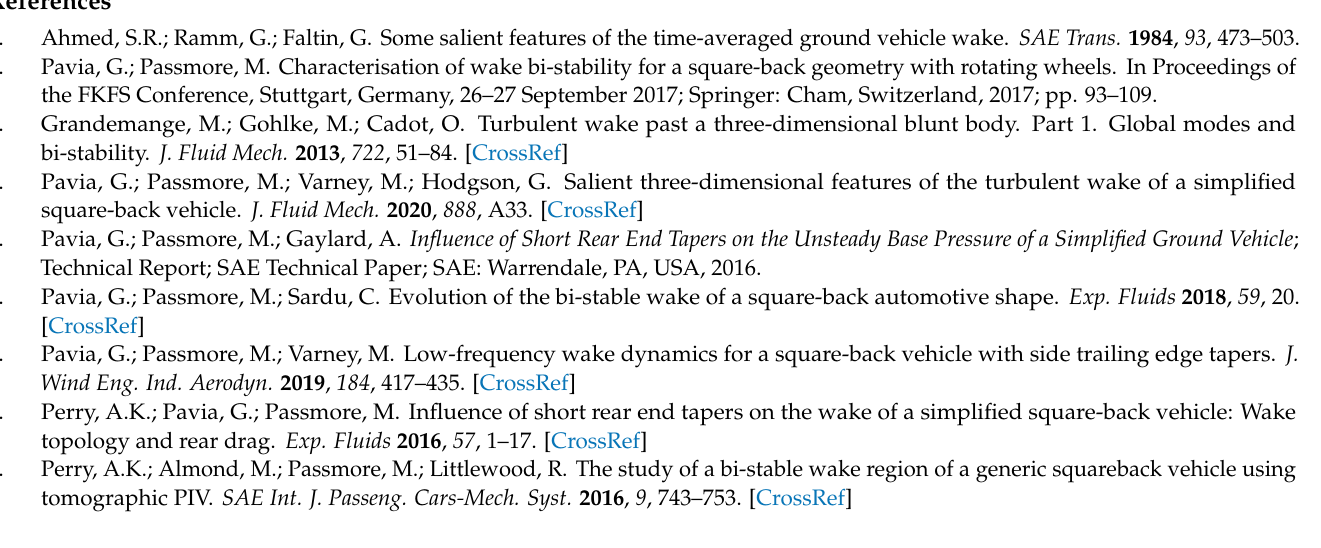
Figure A4. Fluctuations in the surface pressure coefficient C p extracted from ( a ) slices on the vehicle base at ( b ) Z / H = 0.70 (coarse mesh), ( c ) Z / H = 0.45 (coarse mesh), ( d ) Z / H = 0.22 (coarse mesh), ( e ) Z / H = 0.70 (medium mesh), ( f ) Z / H = 0.45 (medium mesh), and ( g ) Z / H = 0.2 (medium mesh) for the rotating wheels